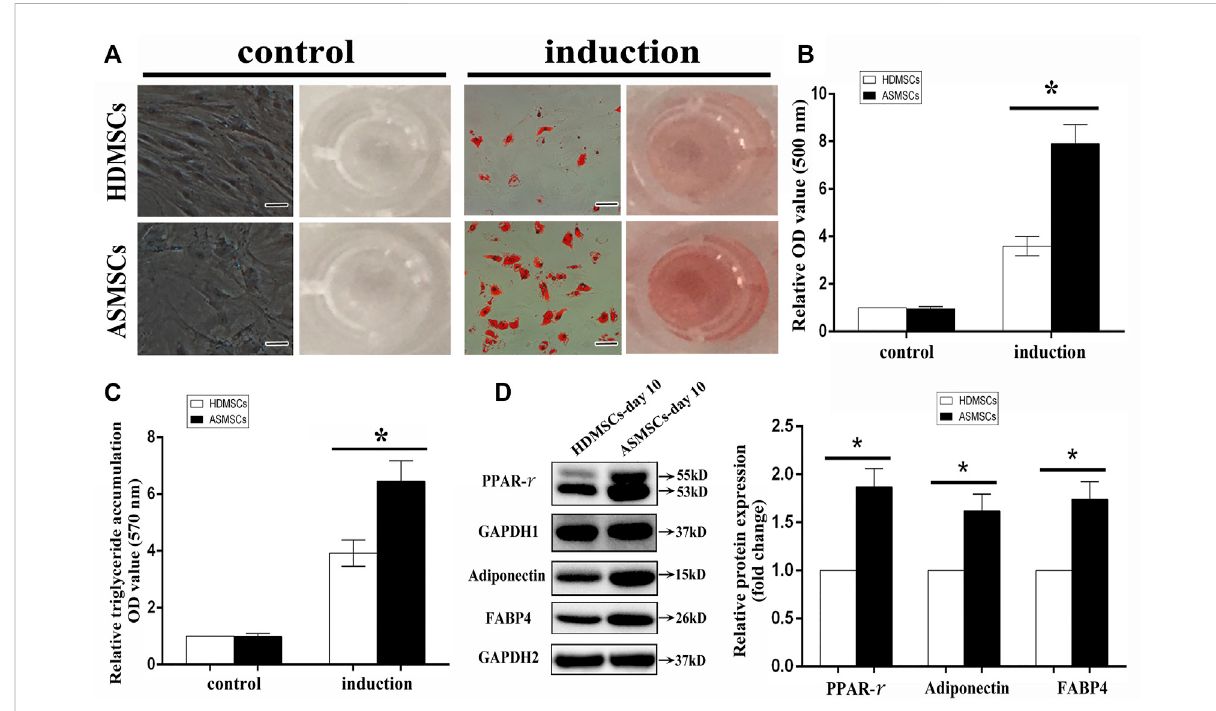
FIGURE 1 ASMSCs had greater adipogenic capacity than HDMSCs. The adipogenic differentiation potential of HDMSCs and ASMSCs were assessed via ORO staining and quanti fi cation and further con fi rmed by quanti fi cation of triglyceride accumulation. (A) ORO staining indicated that ASMSCs displayedmoreintensestainingonDay10(100X,scalebarindicate100 um).ConsistentresultswerealsoobservedinquantifyingofOROstaining (B) and triglyceride accumulation (C) . Moreover, protein expressions of PPAR- γ , FABP4 and adiponectin were higher in ASMSCs than those of HDMSCs (D) . * p <